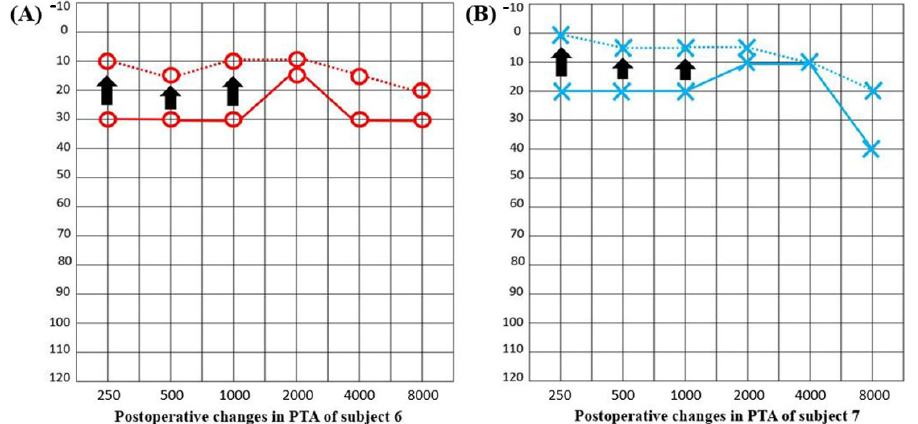
Figure 5. ( A ) Postoperative evaluation of the pure tone averages of subject 6 revealed improved hearing thresholds (by 20 dB at 250 Hz and 15 dB at 500 Hz) (arrows). ( B ) Postoperative evaluation of the pure tone average of subject 7 also revealed improved hearing thresholds (by 20 dB at 250 Hz and 15 dB at 500 Hz) (arrows).